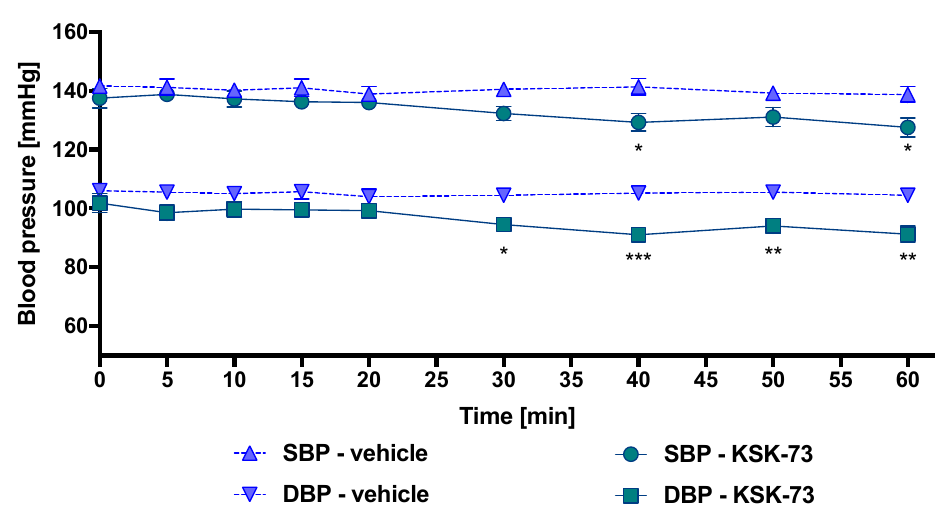
Figure 5. E ff ect of KSK-73 on blood pressure after a single administration (10 mg/kg i.p.). Results are presented as mean ± SEM, n = 6. Statistical analysis: two-way ANOVA with repeated measures, Bonferroni’s post hoc tests, * p < 0.05; ** p < 0.01; *** p < 0.001 vs. vehicle group. SBP—systolic blood pressure; DBS—diastolic blood pressure.